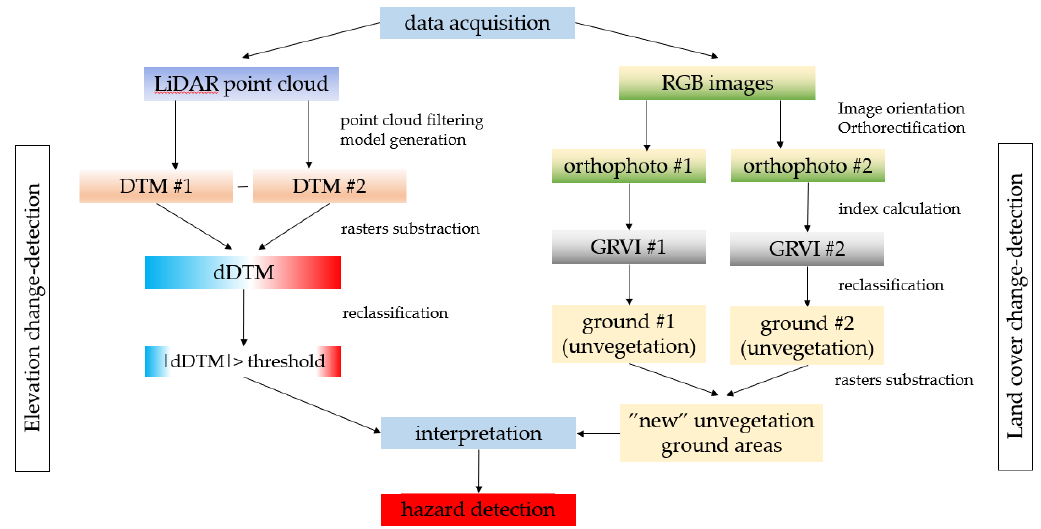
Figure 1. Methodology of detecting a levee hazard area based on the UAS and high-altitude photogrammetry data. LiDAR: Light Detection and Ranging; RGB: Red, Green, Blue; DTM: Digital Terrain Model; dDTM: differential DTM; GRVI: Green-Red Vegetation Index.